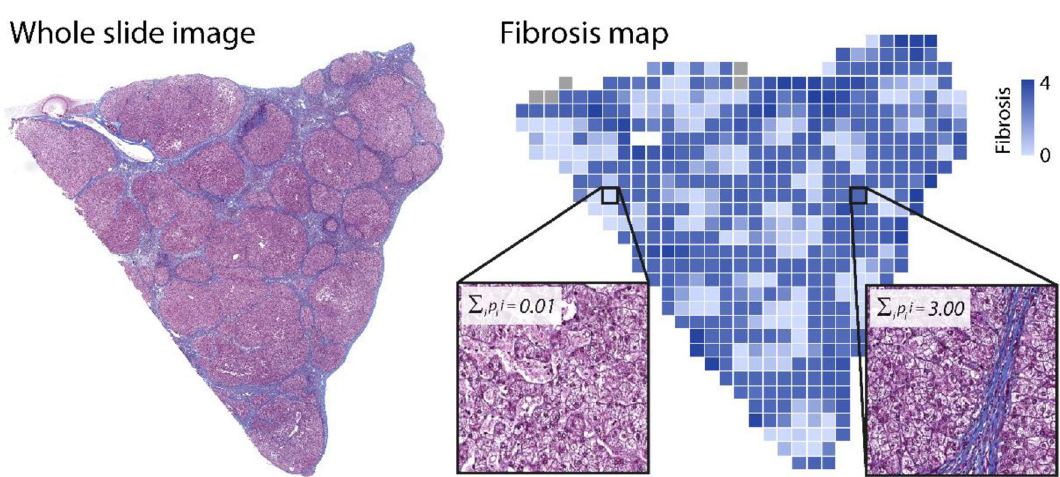
Figure 4. Whole slide image of a liver sample and corresponding feature map of fibrosis. Left: Whole slide image of liver tissue stained in Masson Trichrome. Applying the trained CNN to the whole slide image yielded tile-by-tile results in in the form of a fibrosis feature map, shown at the right. The heatmap was generated using the software Spotfire Analyst 10.10.3 (https:// www. tibco. com/ produ cts/ tibco- spotfi re, Tibco Software Inc., Palo Alto, USA). The two insets at the right illustrate example classifications and the weighted fibrosis score of these two